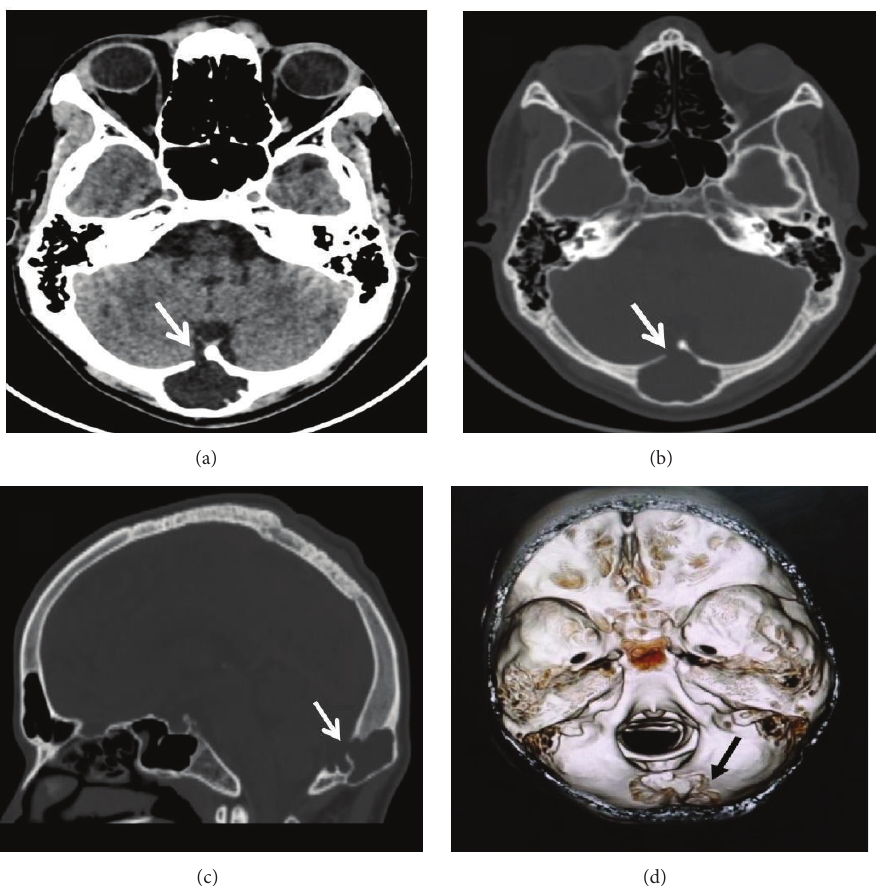
Figure 4: MDCT head (a) axial soft tissue window, (b) axial bone window, (c) sagittal bone window, and (d) VRT images showing CSF density collection in the diploic space of the occipital bone with expansion of the diploic space